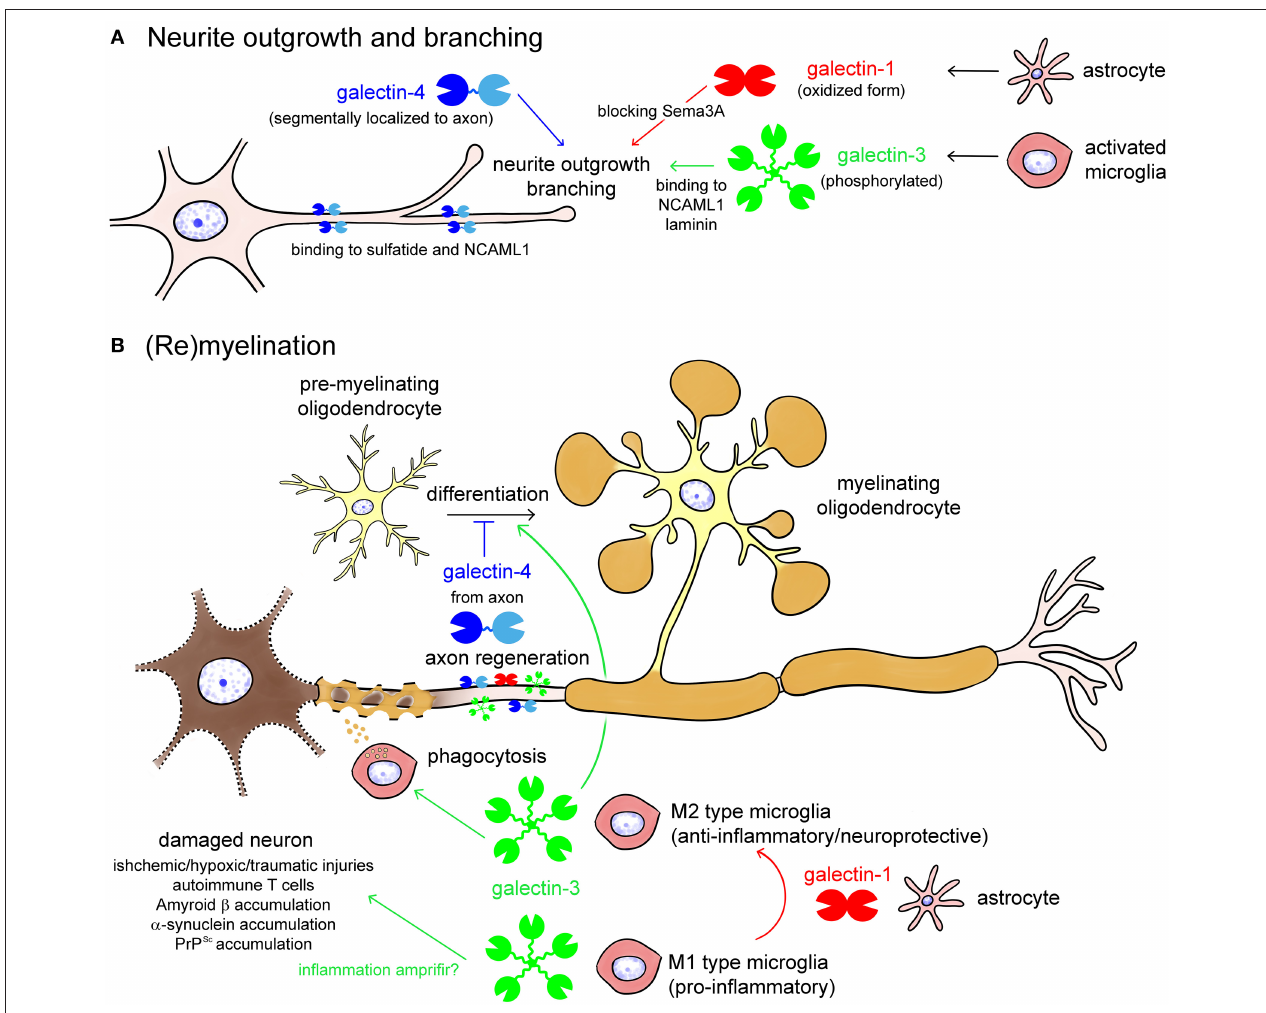
FIGURE 4 | Galectins in neurite outgrowth and branching (A) as well as (re)myelination (B) . Galectin-1 from astrocytes and galectin-3 from activated microglia promote neurite outgrowth and branching, by blocking Semaphorin 3A (Sema3A) pathway or binding to neural cell adhesion molecule L1 (NCAML1) and laminin, respectively (A) . Galectin-4 is segmentary localized to the axon by binding to sulfatide and NCAML1, regulating axonal growth and branching (A) . Oxidization and phosphorylation of galectin-1 and galectin-3, respectively, enhances neuroprotective activities of them (A) . In damaged neurons, galectin-3 from M1 type microglia enhances inflammation, whereas galectin-3 from M2 type microglia promotes phagocytic cleaning and oligodendrocyte differentiation (B) . Galectin-1, possibly from astrocytes, induces shift from the M1 to M2 phenotype of activated microglia and oligodendrocyte differentiation. Galectin-4 from regenerating axon inhibits maturation of pre-myelinating oligodendrocyte to determine the timing of